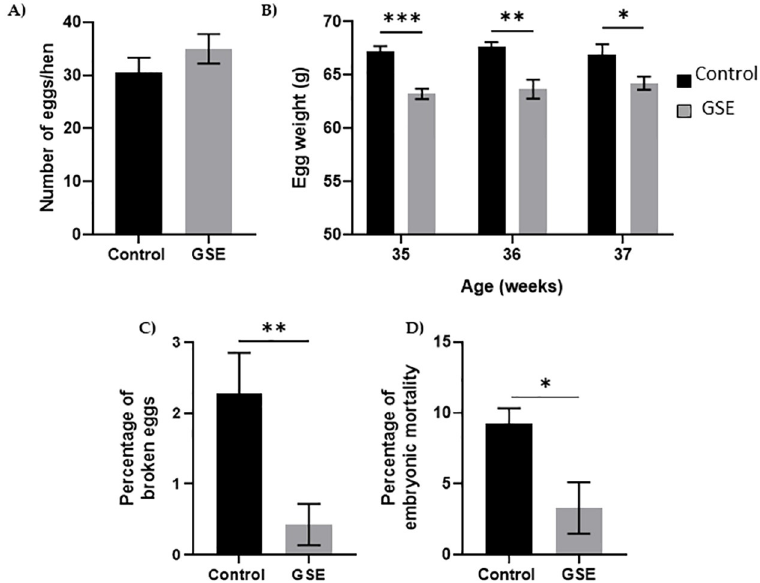
Fig 6. Reproductive performance. ( A ) Cumulative egg number during a 60-day period (29-37-week- old hens) (n = 20 per group), (B) Kinetics of egg weight during the reproductive period, (C) Percentage of broken eggs, (D) Percentage of embryonic mortality in incubated egg was measured in 200 eggs from 20 hens per group. Results are presented as means ± SEM. � , p < 0.05. �� , p < 0.01. ��� , p < 0.001.